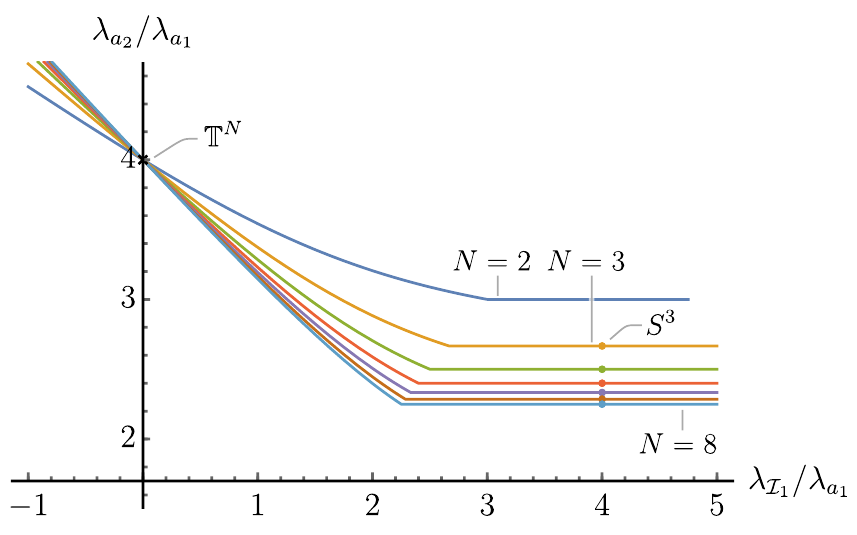
Figure 2 . Upper bounds on the ratio of the (cid:12)rst distinct nonzero eigenvalues of the scalar Laplacian on closed Einstein manifolds with R (cid:21) 0 and N = 2 ; : : : ; 8 for di(cid:11)erent values of the lightest Lichnerowicz eigenvalue, assuming that g a = 0 when (cid:21) a = (cid:21) a . The (cid:12)lled circles correspond to 1 a 1 a 1 round N -spheres and the cross corresponds to long (cid:13)at N